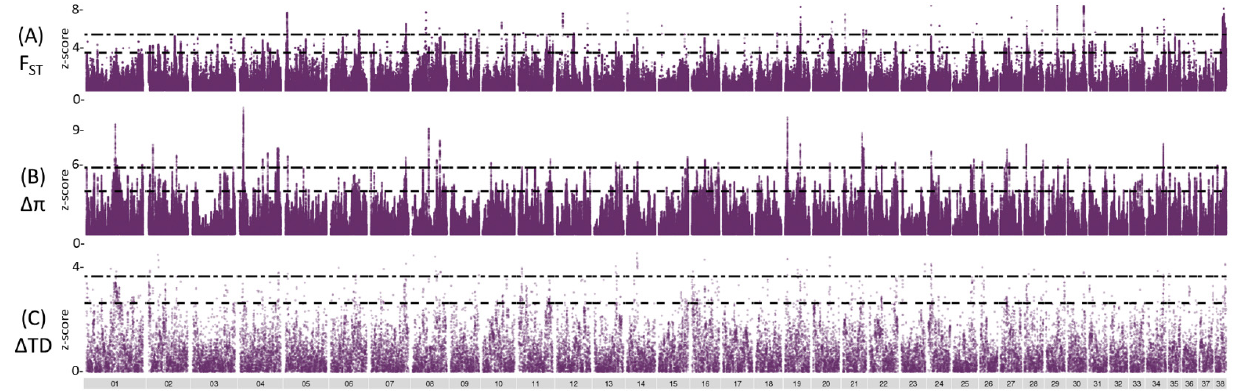
Figure 2. Genome-wide allele frequency SCA case ( n = 12) and SCA control ( n = 11) individuals from overlapping 50 Kb windows in 1 Kb steps. ( A ) Manhattan plot of z-transformed F ST values. Dashed line indicated top 1% (z-score = 3.48). Double dashed line indicated top 0.1% (z-score of 5.41). ( B ) Distribution plots of ∆π values. Dashed line indicated top 1% (z-score = 3.77). Double dashed line indicated top 0.1% (z-score of 5.81) ( C ) Distribution plots of ∆ Tajima’s D values. Dashed line indicated top 1% (z-score = 2.64). Double dashed line indicated top 0.1% (z-score of 3.67).